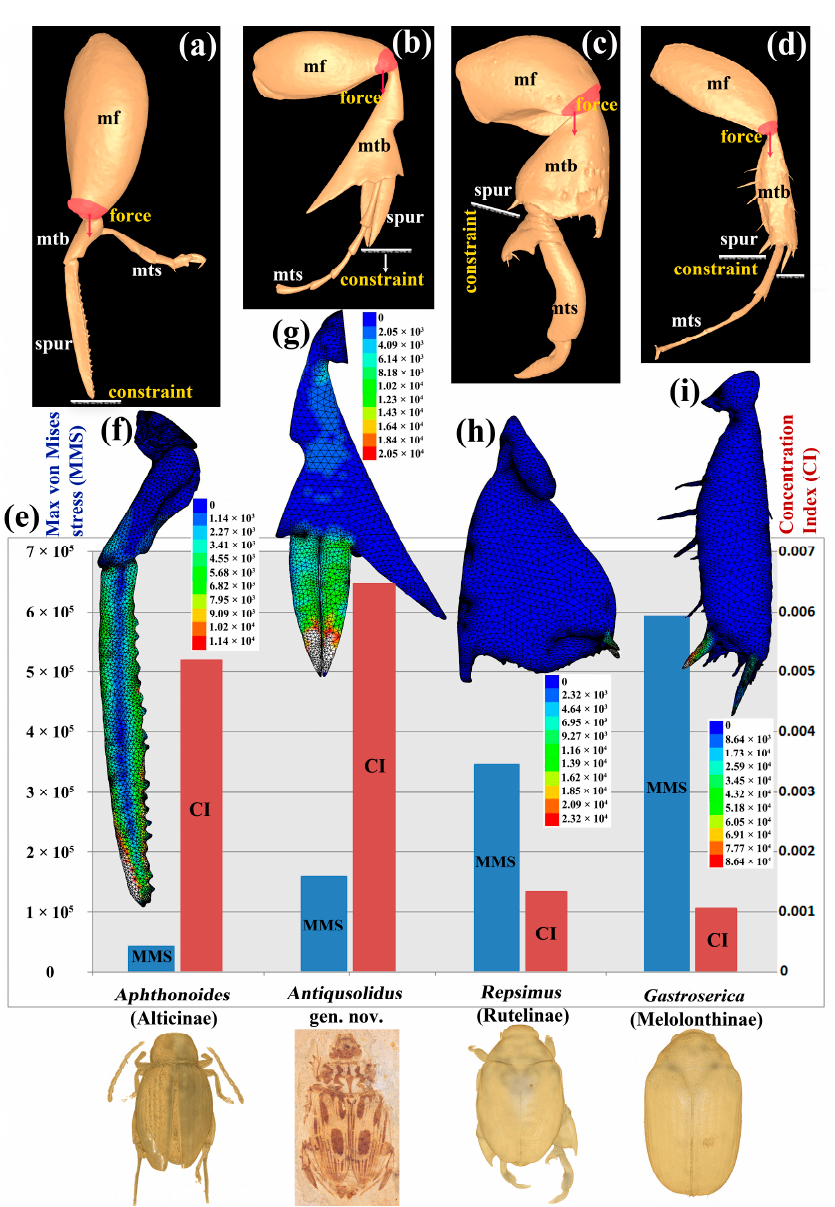
Figure 3. Possible springing function of the hind legs using FEA simulation. ( a – d ) Three-dimeniosnal models of hind legs. Boundary conditions: all models were transformed in Geomagic Studio 12 with the longer spur of hind tibiae in the Y-direction; the constraints were set at the tip of the spurs. The force loads were applied to the hind tibial base in the Y-direction; the boundary condition sets mimic the scene when the beetle falls down. Abbreviations: mf: metafemur; mtb: metatibia; mts: metatarsi; sp: spur. ( e ) The comparison of the maximal von Mises stress (MMS, blue histogram) and Concentration Index (CI, red histogram) of the high von Mises stress among all models. ( f – i ) Three-dimensional hind legs with von Mises stress contours. ( a , f ) Aphthonoides armipes (Alticinae). ( b , g ) Antiqusolidus maculatus sp. n. (fossil). ( c , h ) Repsimus manicatus (Rutelinae). ( d , i ) Gastroserica kucerai (Melolonthinae).